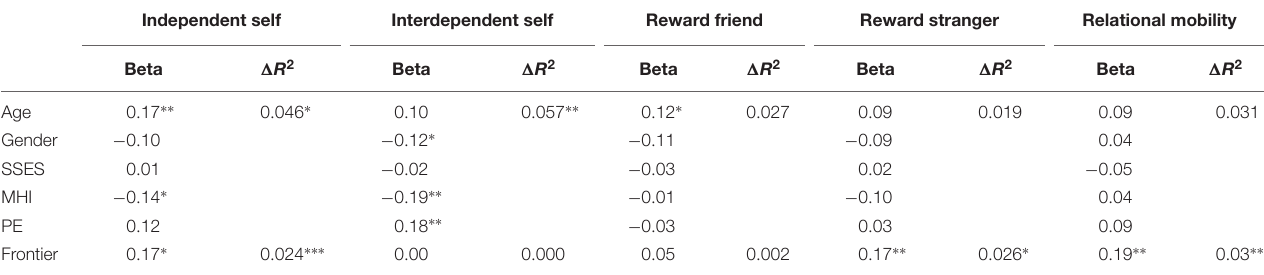
TABLE 2 | Summary of regression predicting independent/interdependent self and reward friend/stranger and relational mobility as a function of Demographic and Relational mobility and Voluntary Frontier Settlement. Independent self